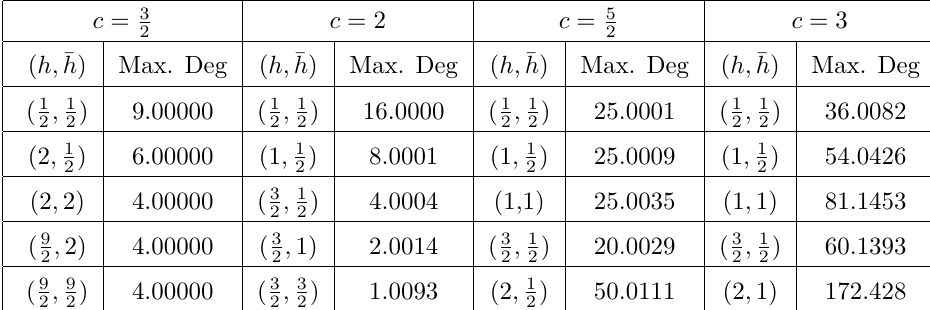
Table 1 . The maximum value of degeneracies for the low-lying states in a putative CFTs on the plateau of (cid:12)gure